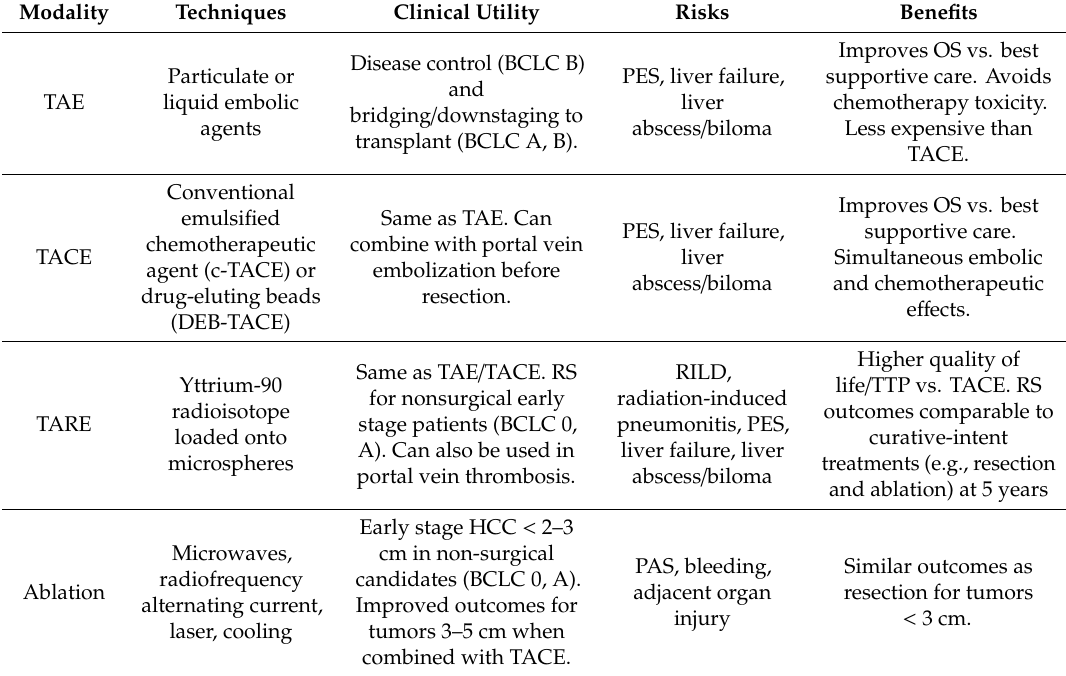
Table 1. Summary of Locoregional Therapy Options for Hepatocellular